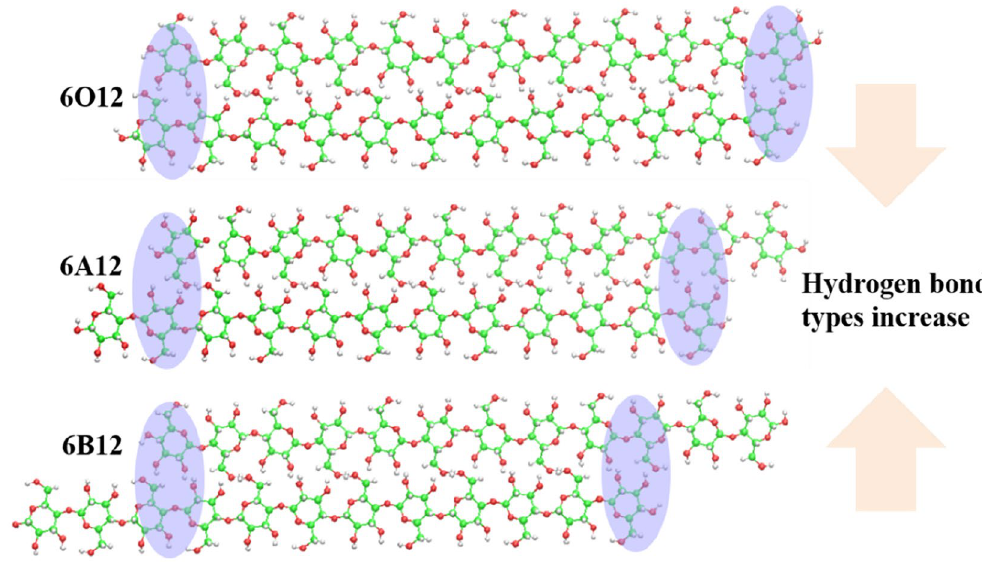
Figure 4. The influence of inclined facet on the hydrogen bond formation. Neighbor chain weak interaction of the terminal anhydroglucose varies in inclined crystal facets for cellulose II nanocrystal